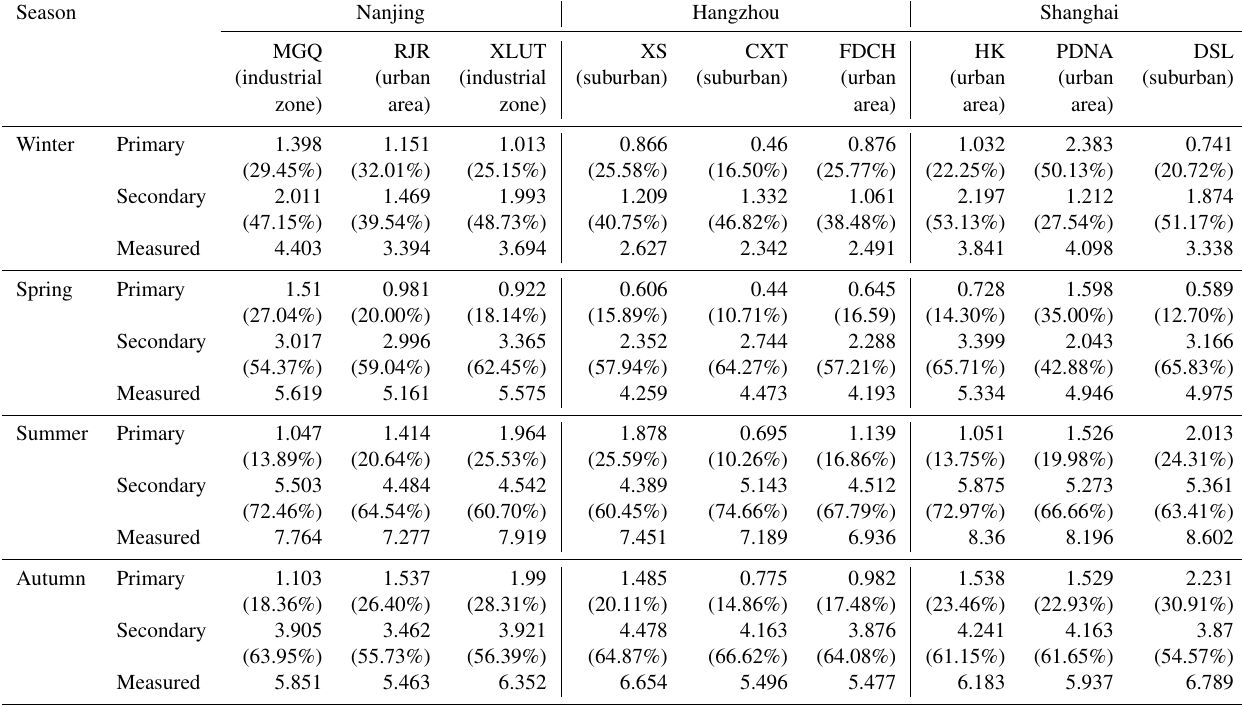
Table 3. Seasonal average of the measured HCHO concentrations (ppbv) and absolute and relative contributions from different sources from 2015 to 2017 in Nanjing, Hangzhou, and Shanghai.The values in parentheses represent the contributions from different sources; lines 1–2 in each season refer to primary HCHO, lines 3–4 refer to secondary HCHO, and line 5 refers to measured HCHO.